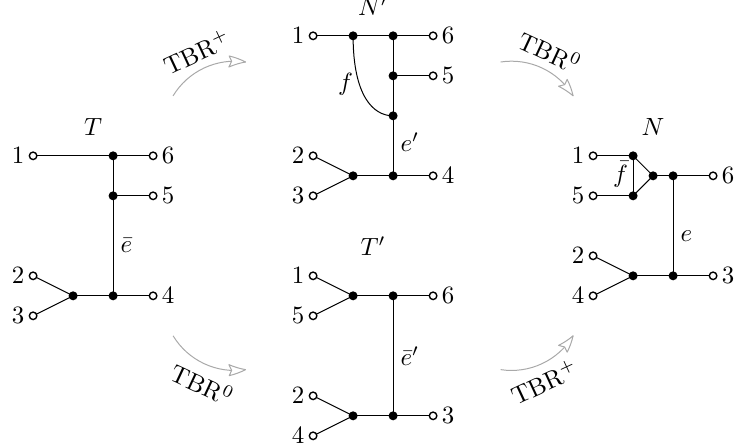
Figure 9: There is a TBR-sequence from T to N that first adds f with a TBR + and then moves e (cid:48) to e with a TBR 0 . From this, a TBR-sequence can be derived that moves ¯ e to ¯ e (cid:48) with a TBR 0 and then adds ¯ f with a TBR +